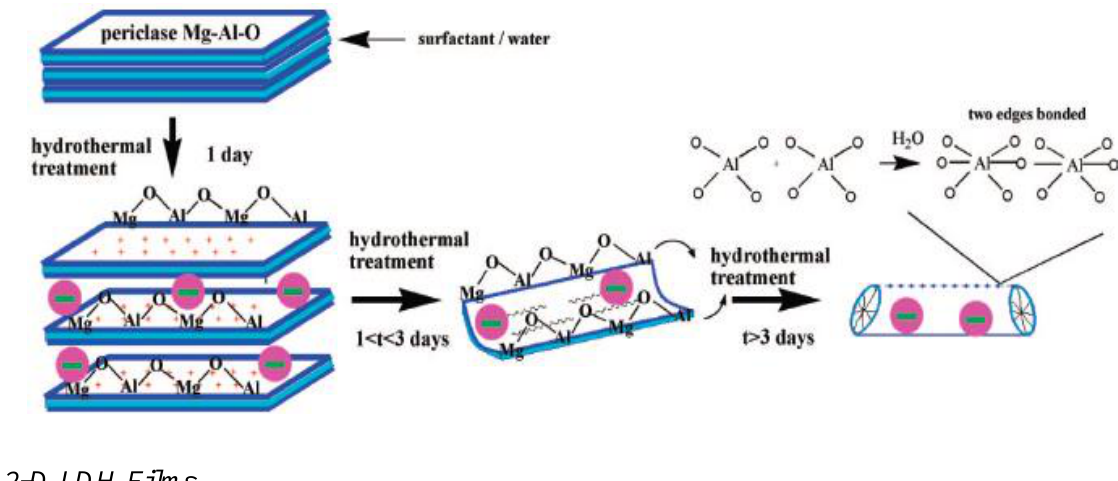
Figure 5. Possible mechanism for the folding of layers of LDH to give fibrous hydrotalcites. Reprinted with permission from [20], © American Chemical Society,